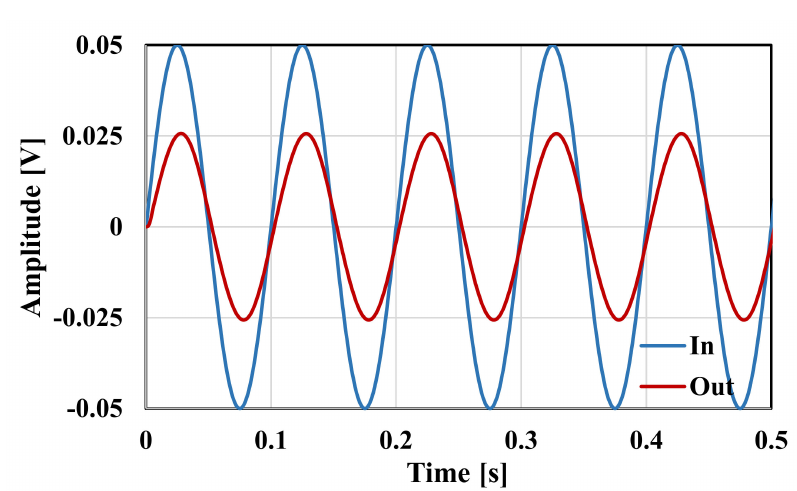
Figure 12. The cut-o ff frequency versus the bias current.